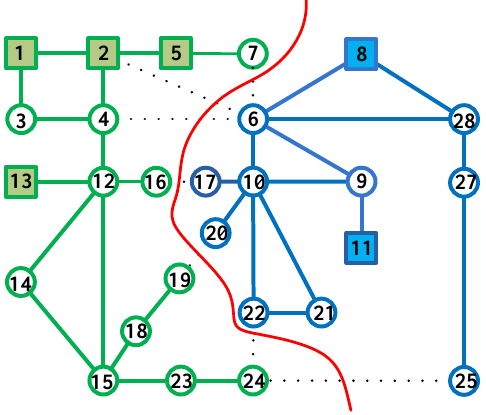
Figure 8. The new solution generated by moving Node 7 to G